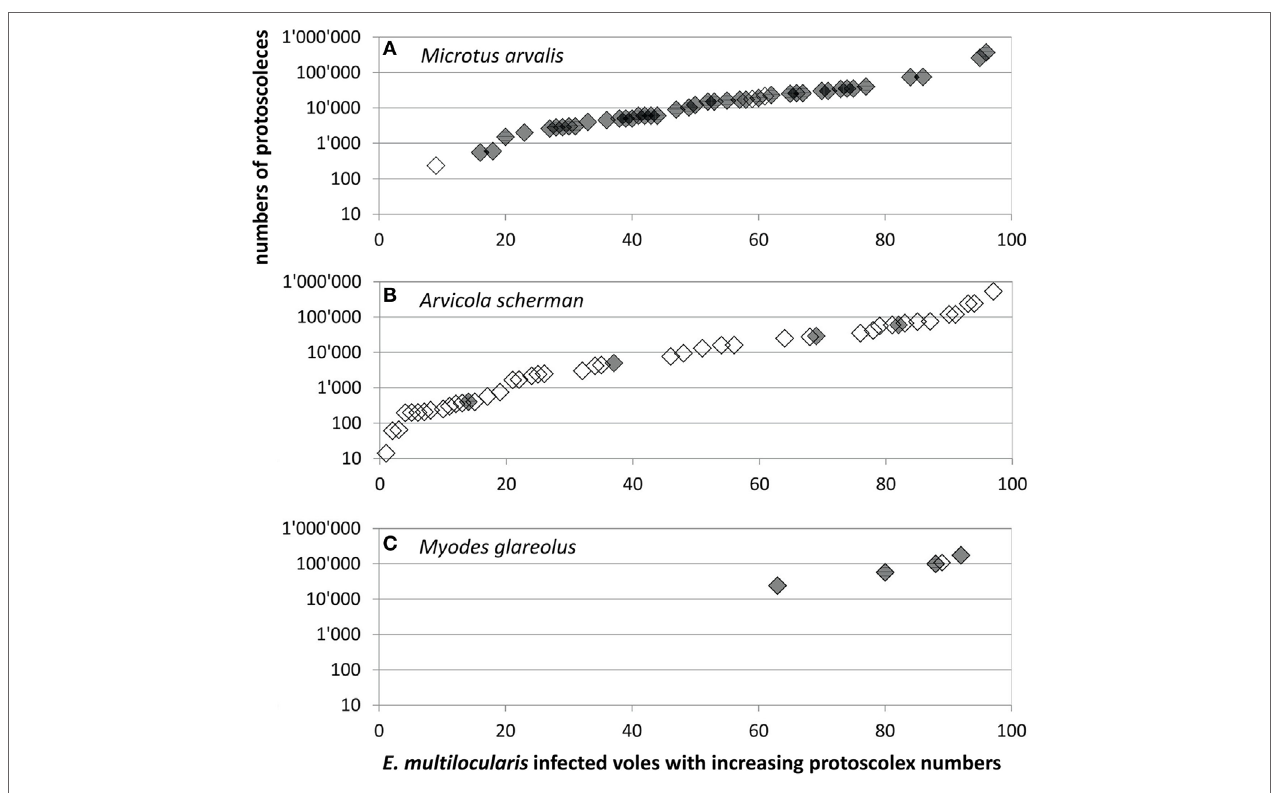
FigUre 3 | Protoscoleces burden in (a) 44 Microtus arvalis , (b) 46 Arvicola scherman , and (c) 5 Myodes glareolus with fertile Echinococcus multilocularis infections which were trapped for this (gray symbols, N = 49) and for former (blank symbols, N = 46) studies (40, 41). Data shown in Table S1 in Supplementary